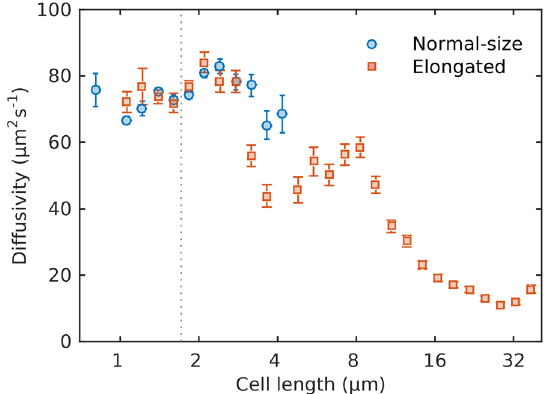
Figure 4. Bacterial diffusivities vs . cell length. Blue circles represent control cells, and red squares represent cephalexin treated cells. Vertical dotted line marks the average length of untreated E. coli . Error bars are the standard error of the estimates. Note the base-2 logarithmic axis for cell